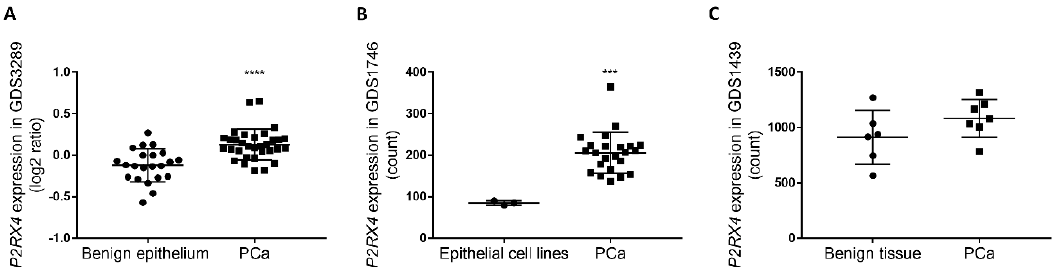
Figure 5. Clinical data suggests an association between P2RX4 expression and PCa malignancy. Clinical datasets with accession numbers GDS1439 [34], GDS1746 [35], and GDS3289 [36] were downloaded from Gene Expression Omnibus (https://www.ncbi.nlm.nih.gov/geo/) [33]. The expression of the P2RX4 gene was quantitatively compared between primary PCa samples and ( A )